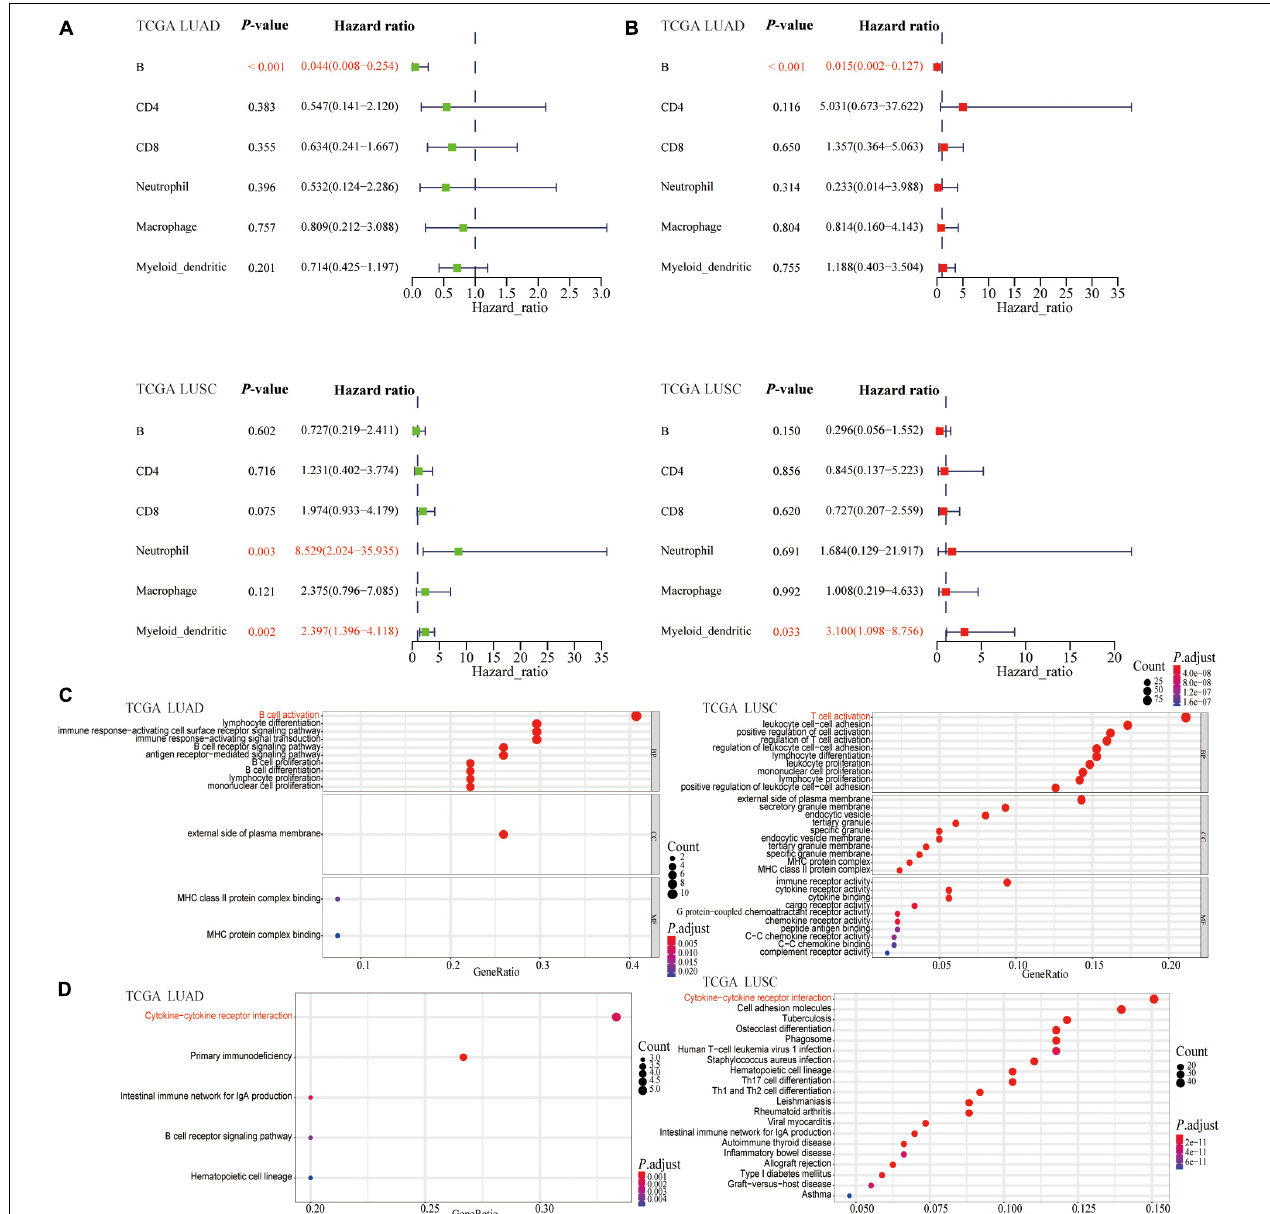
FIGURE 3 | The Cox regression analysis and function enrichment analysis. (A) The univariate Cox regression (green) and (B) multivariate Cox regression (red) analysis of six types of TIICs in LUAD and LUSC. The vertical dashed line represents HR = 1. B cell was a protective factor for LUAD (HR < 1), whereas DC1 was a harmful factor of LUSC (HR > 1). (C) GO and (D) KEGG enrichment analysis of 29 genes strongly related to B cell in TCGA-LUAD and 487 genes highly related to DC1 in TCGA-LUSC, respectively. The horizontal axis, gene ratio, represents the proportion of highly related genes contained in the corresponding term to the total highly related genes. The size of the dot indicates the number of highly related genes contained in the corresponding